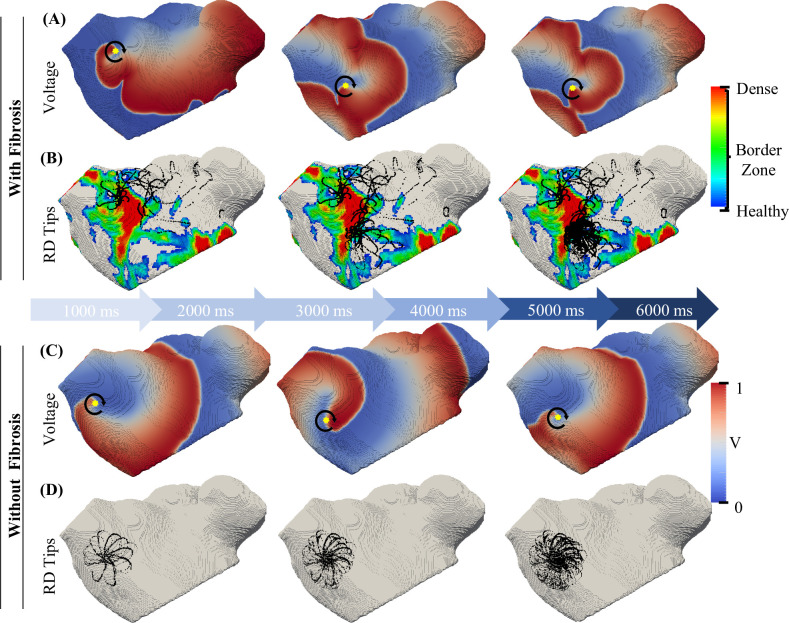
The effect of fibrosis on the RD dynamics in a patient-specific LA model.A & C: the colour-coded voltage maps (normalised, so that 0 is rest state and 1 is maximal activation) in the LA of Patient 3 over 6s of simulation with the yellow dot indicating the RD tip and the arrow pointing to the direction of rotation. B & D: the corresponding RD trajectories (in black) superimposed on the fibrosis distribution. In simulations with fibrosis (A-B), the primary RD drifts around and across the fibrotic patch within the first 1s and thereafter stabilises at a distinctive location within the fibrotic BZ. However, in the same simulation without fibrosis (C-D), the primary RD remains at the location of its initiation.